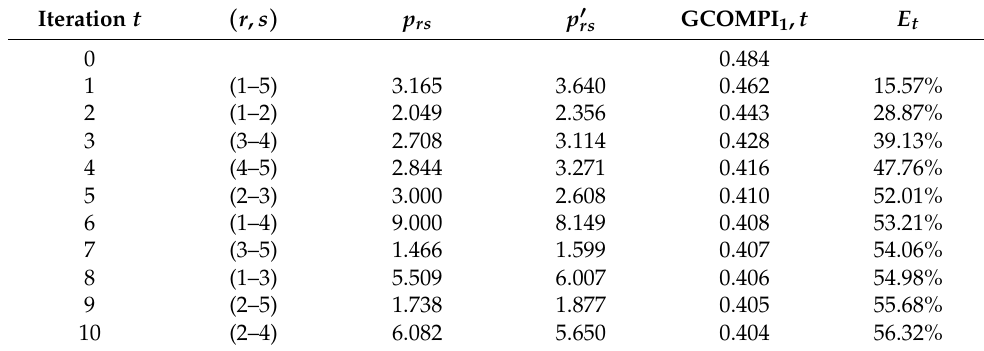
Table 2. Information on the iterations of the procedure with ρ = 15%.